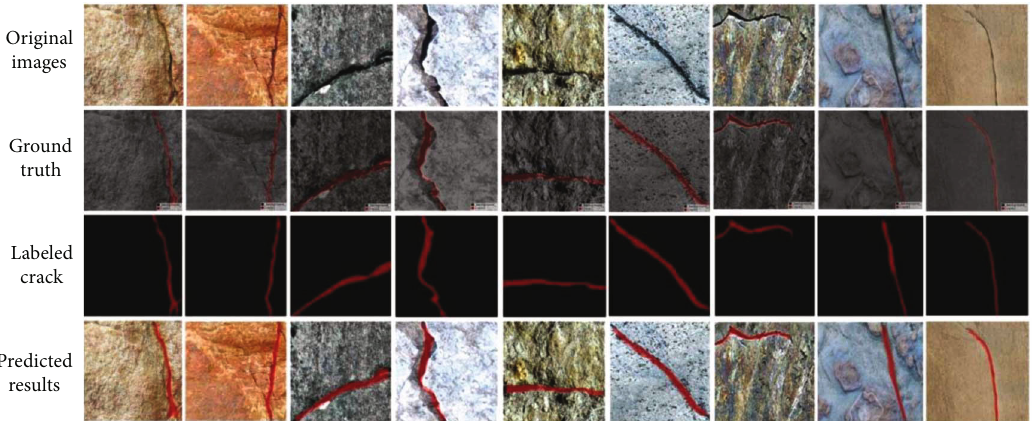
Figure 14: Examples of predicted results of the multi-CrackNet on single-crack